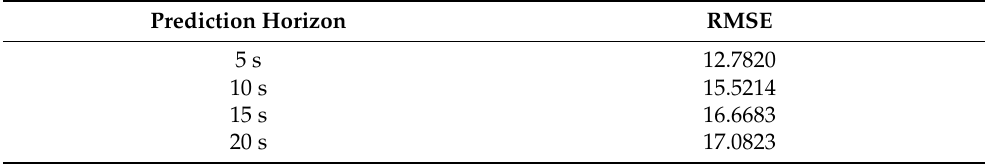
Table 3. RMSE of different predicted